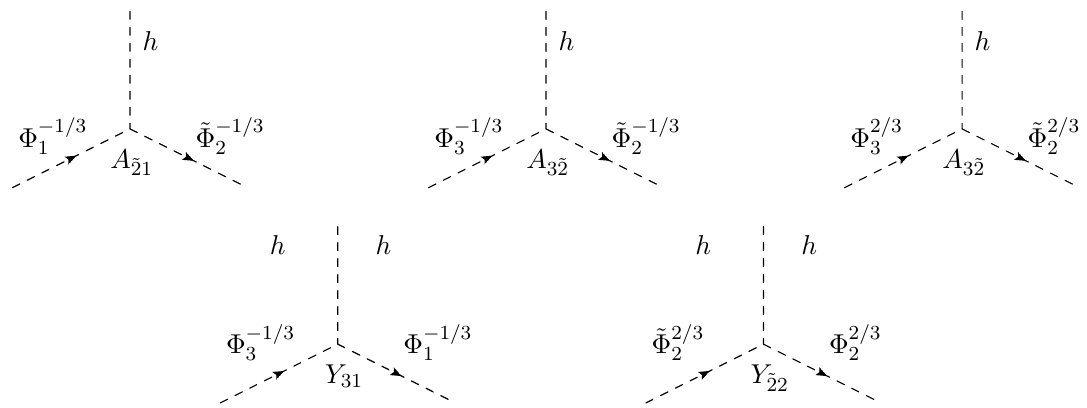
Figure 1. Feynman diagrams depicting LQ-Higgs interactions. Here the physical Higgs h can be replaced by its vev, leading to mixing among the